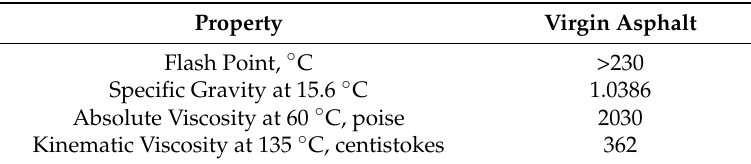
Table 1. Physical properties of virgin asphalt binder (PG64-22) [26].